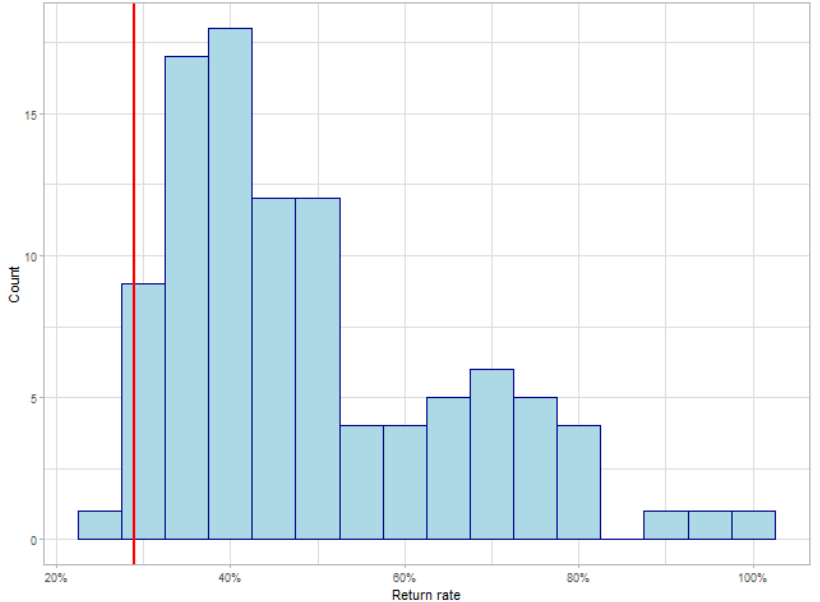
Figure 4. Histogram for return rates of 100 trials by using our fuzzy ensemble model. The red vertical line indicates the SP100 index return rate.